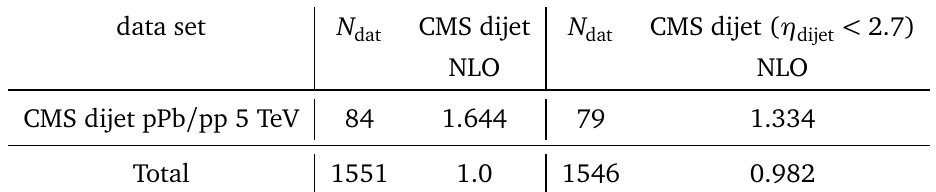
Table 4: Same as Table 3, χ 2 calculated excluding the last η p avg T ,dijet